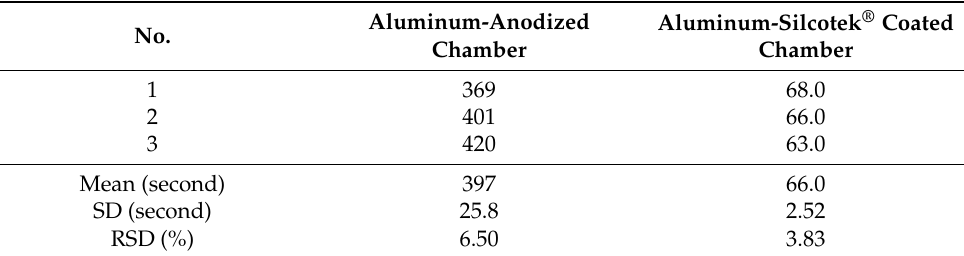
Table 4. Response time of the analyzer from blank to span for different gas chamber coating materials.